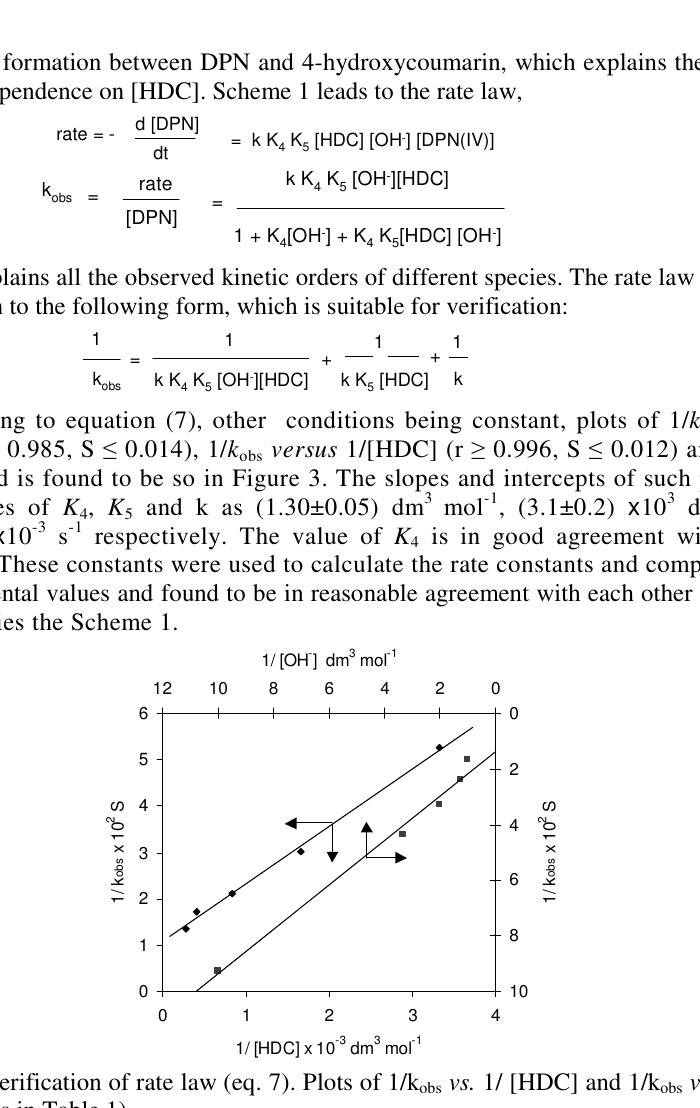
vs. 1/ [HDC] and 1/k obs